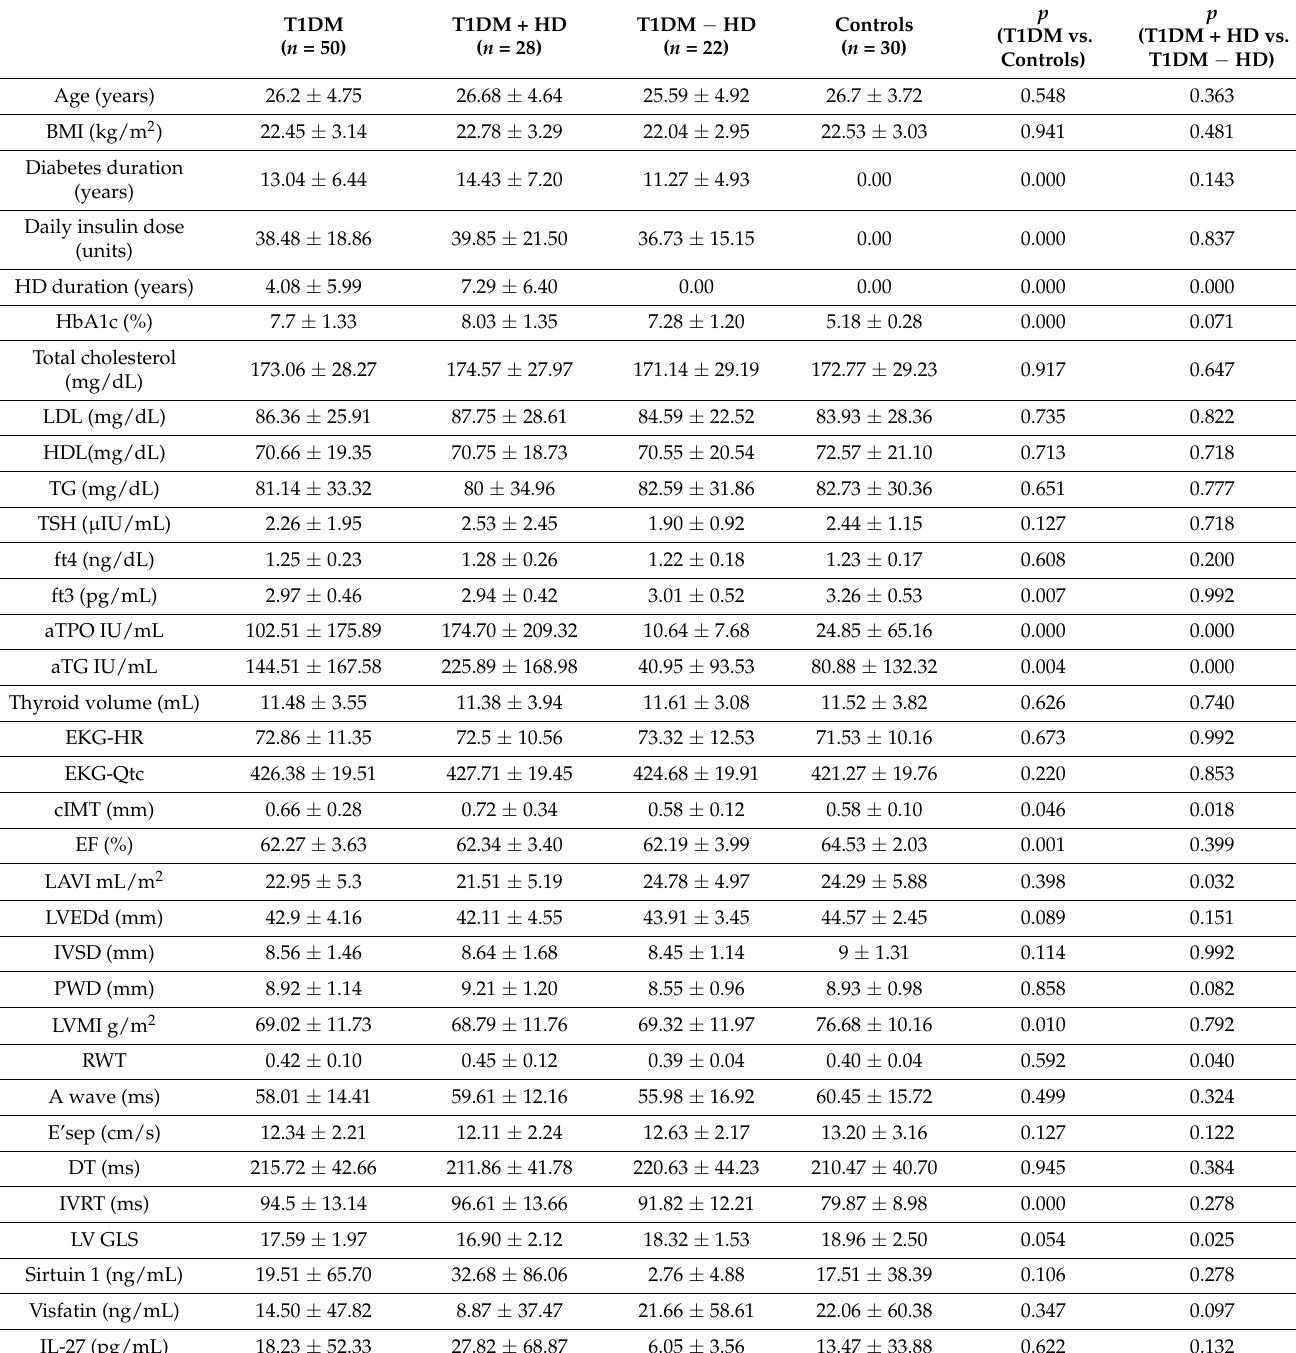
Table 1. The main demographic and clinical characteristics of each test